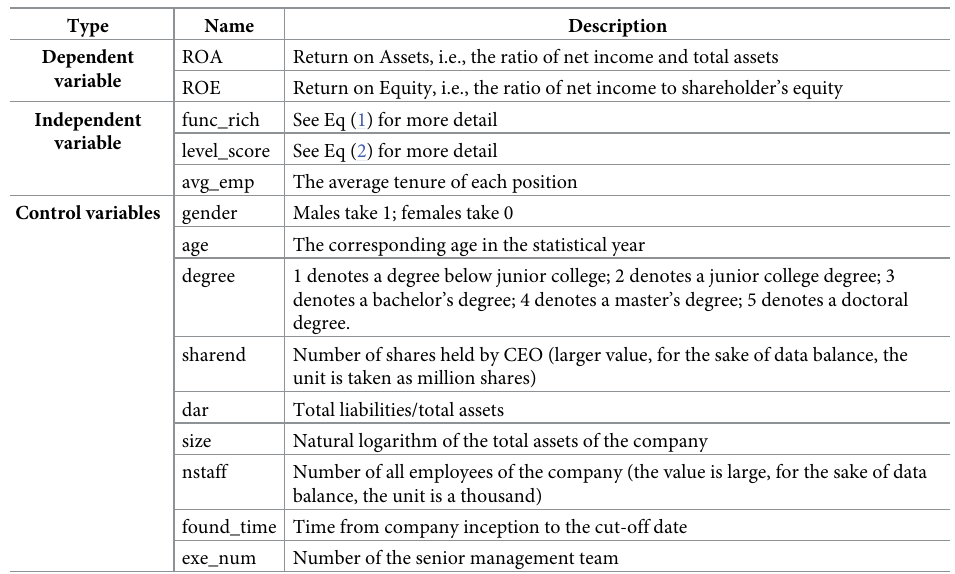
Table 1. Variable definition.